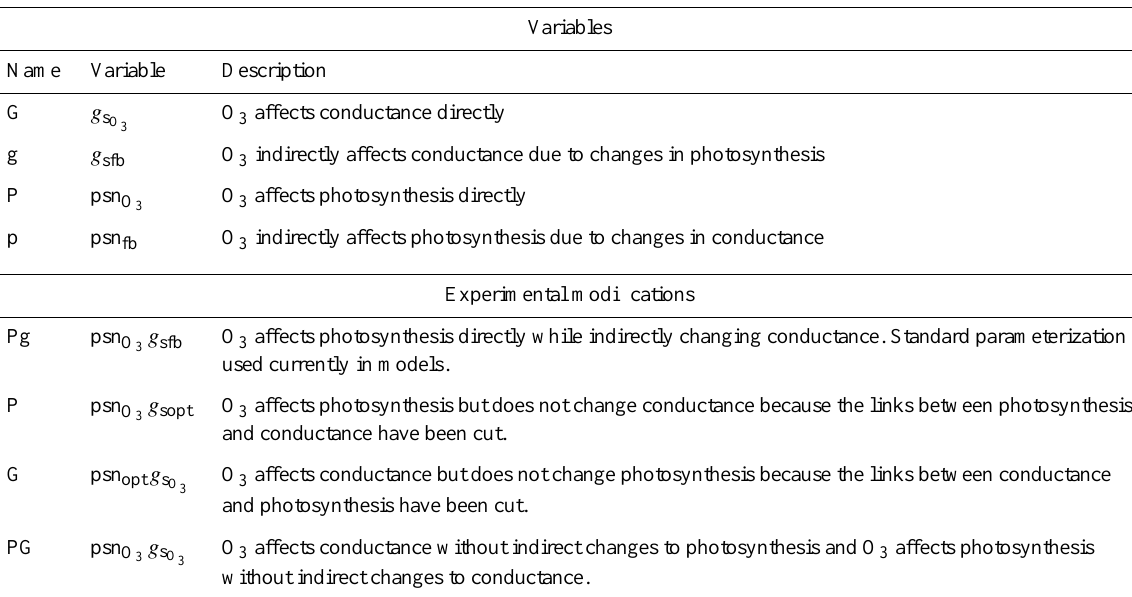
Table 1. Description of the names, variables and simulations in the CLM.